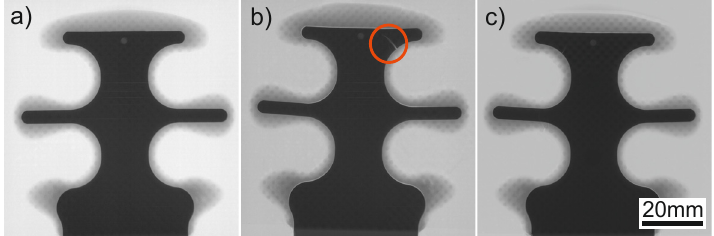
Figure 14. Two-dimensional projections of the hybrid specimens; ( a ) reference, ( b ) after dynamical testing @23 °C, and ( c ) @60 °C, respectively.